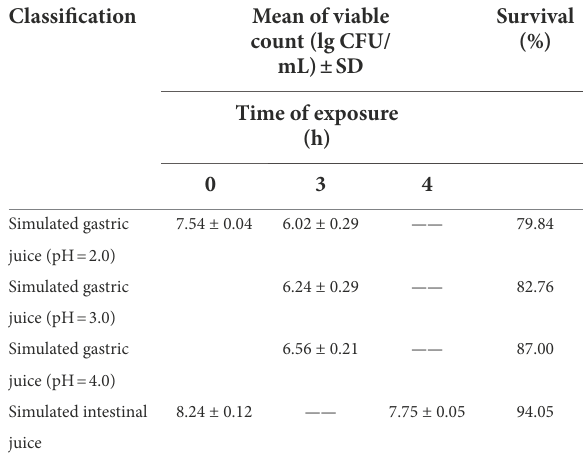
TABLE 4 Survival of L. salivarius S01 in simulated gastric and intestinal juices environments. Classification